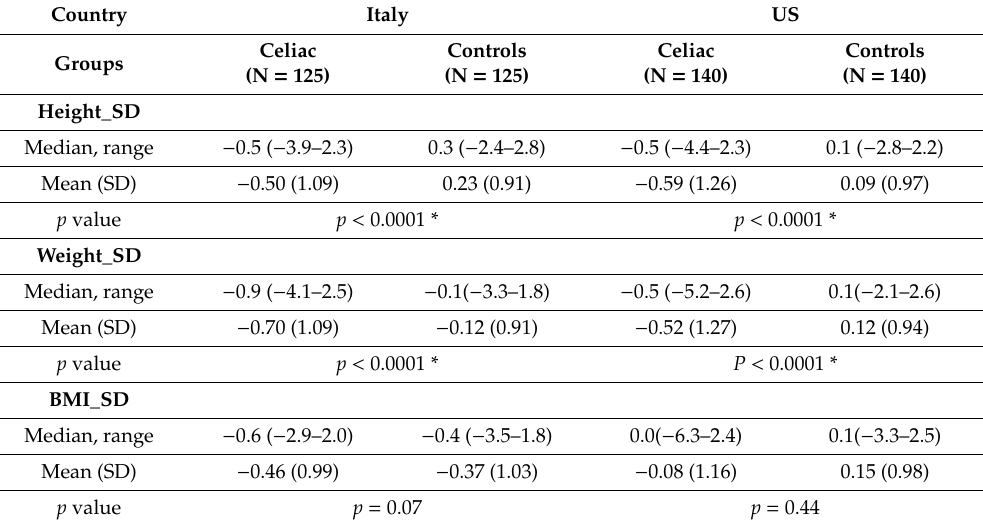
Table 2. Comparison between celiac and healthy children at time 0.